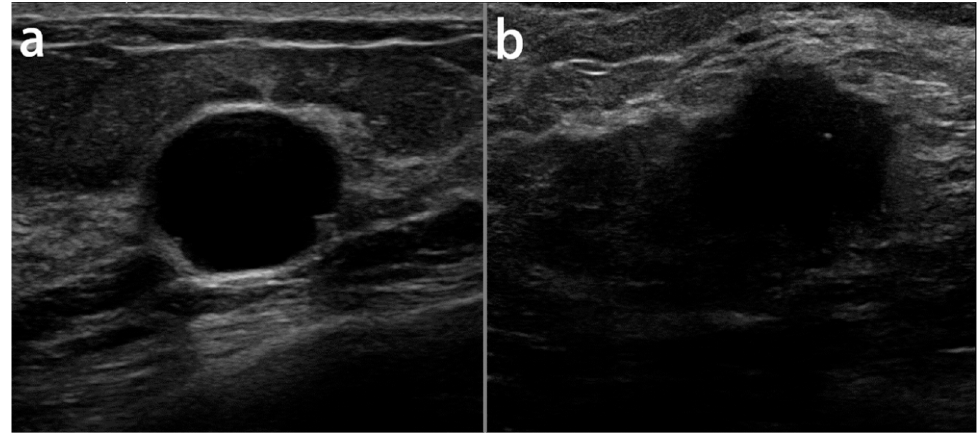
Figure 2. The samples of benign ( a ) and malignant ( b ) lesions in breast ultrasound images.